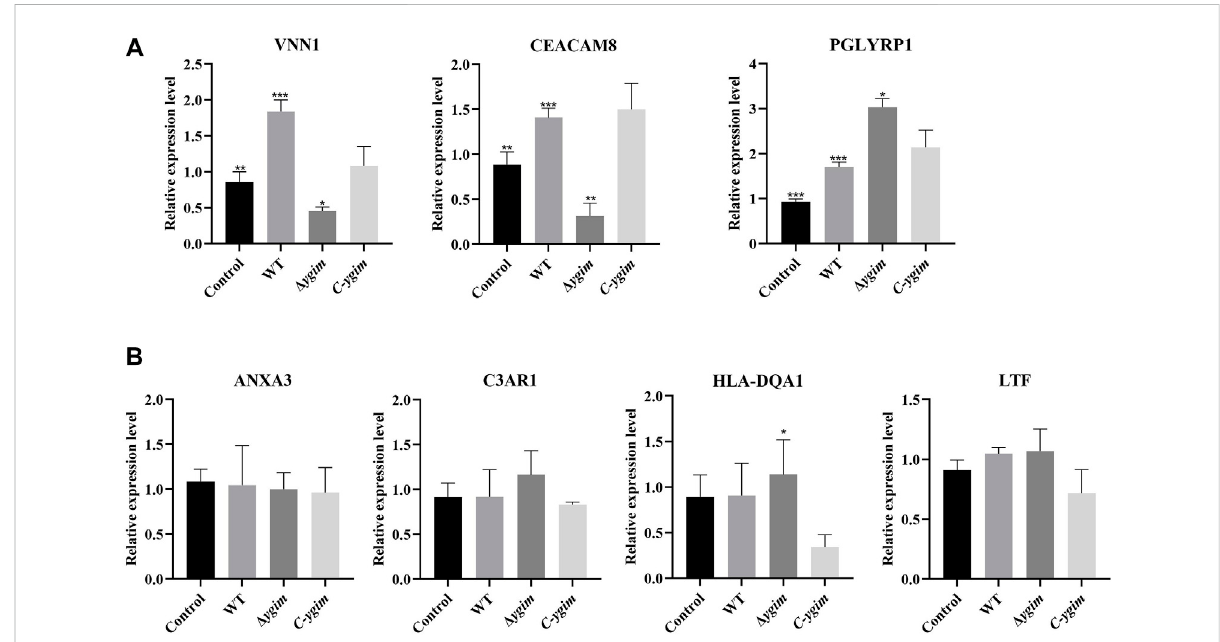
The relative expression of mRNA in K. pneumoniae wild-type, Δ ygiM and C-ygiM strains. (A) Positive targets of mRNA: VNN1, CEACAM8, PGLYRP1wereconsideredtobestatisticallysigni fi cantintheinfectionof K.pneumoniae control,wildtypeand Δ ygiM groups(*: p < 0.05,**: p <